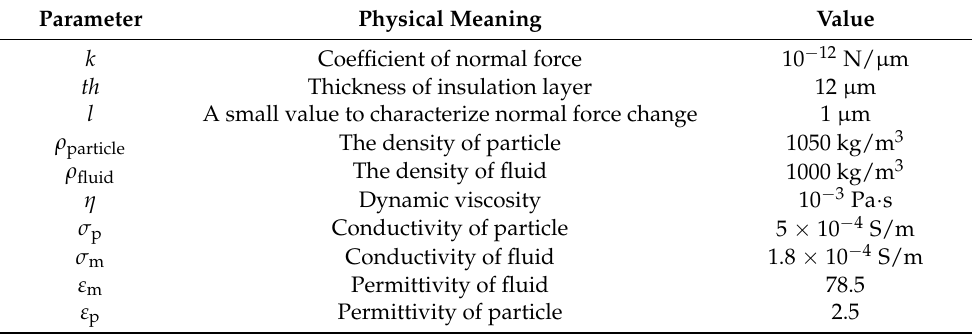
Table 1. Parameters used in models studying the tumbling motion of pearl